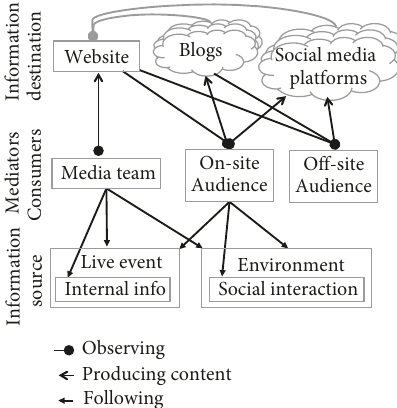
Figure 3: Emitting information (Second Screen